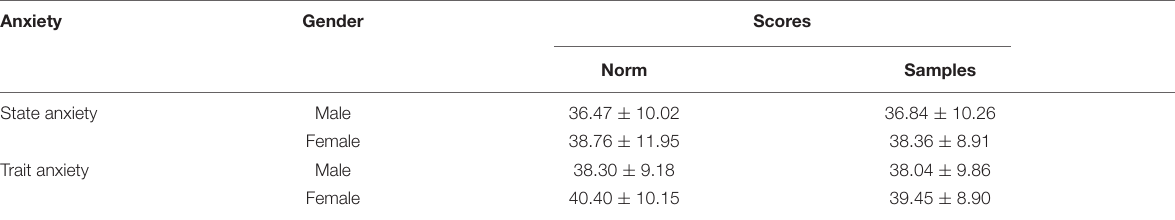
TABLE 2 | The Z -test analysis results of state and trait anxiety compared with norm.